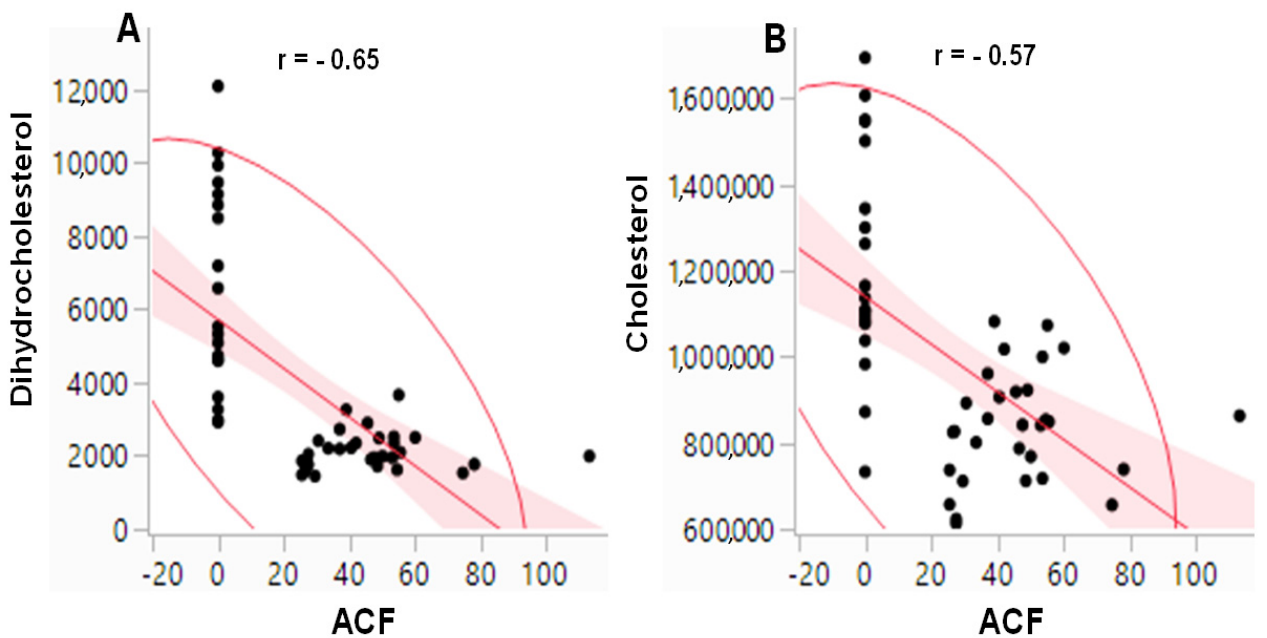
Figure 4. Scatterplot analysis of the correlation between ( A ) the number of ACF and the relative concentrations (quantifier ion peak heights) of dihydrocholesterol; ( B ) the number of ACF and the relative concentrations (quantifier ion peak heights) of cholesterol. With n = 50 each set, both ( A , B ) show an inverse association with a significant Spearman correlation ( p < 0.0001), respectively.